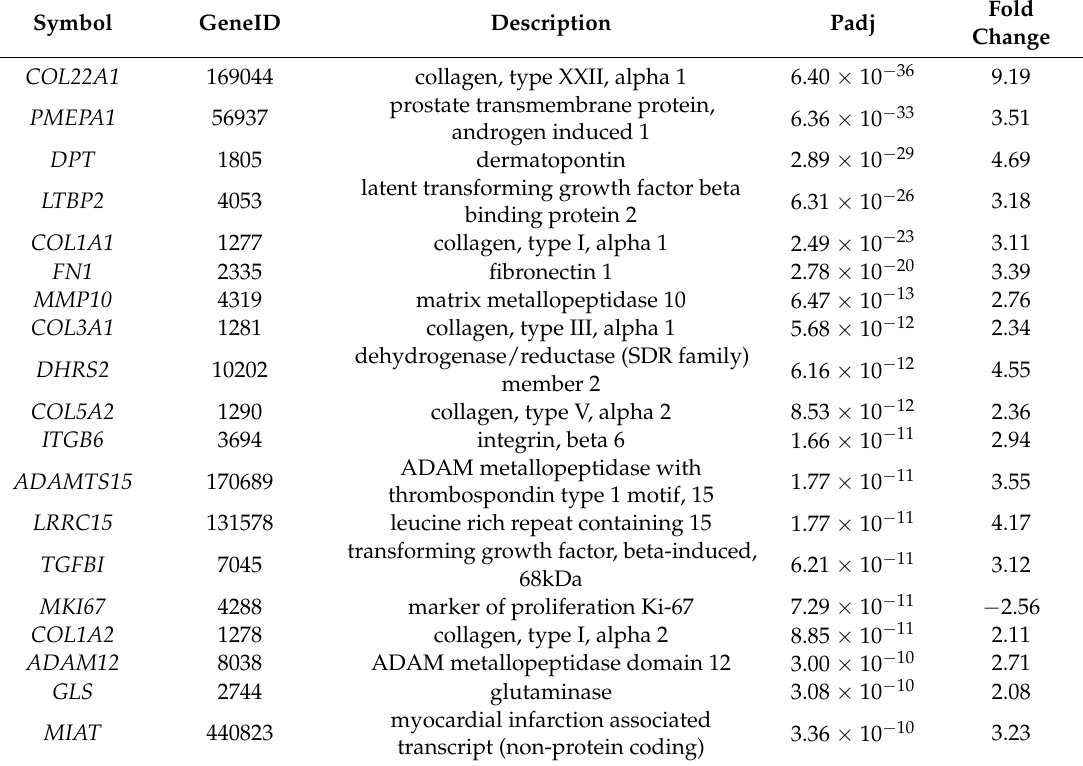
Table 1. The significant differentially expressed (DE) messenger RNA (mRNAs) as determined by vehicle control for 48 h. The top 100 most significant DE mRNAs ranked by FDR (padj) are presented. Symbol